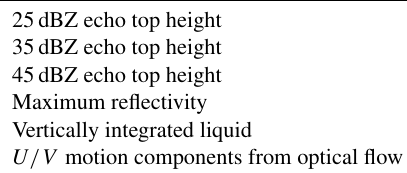
Table B2. Variables from the NEXRAD radar adopted in this study.